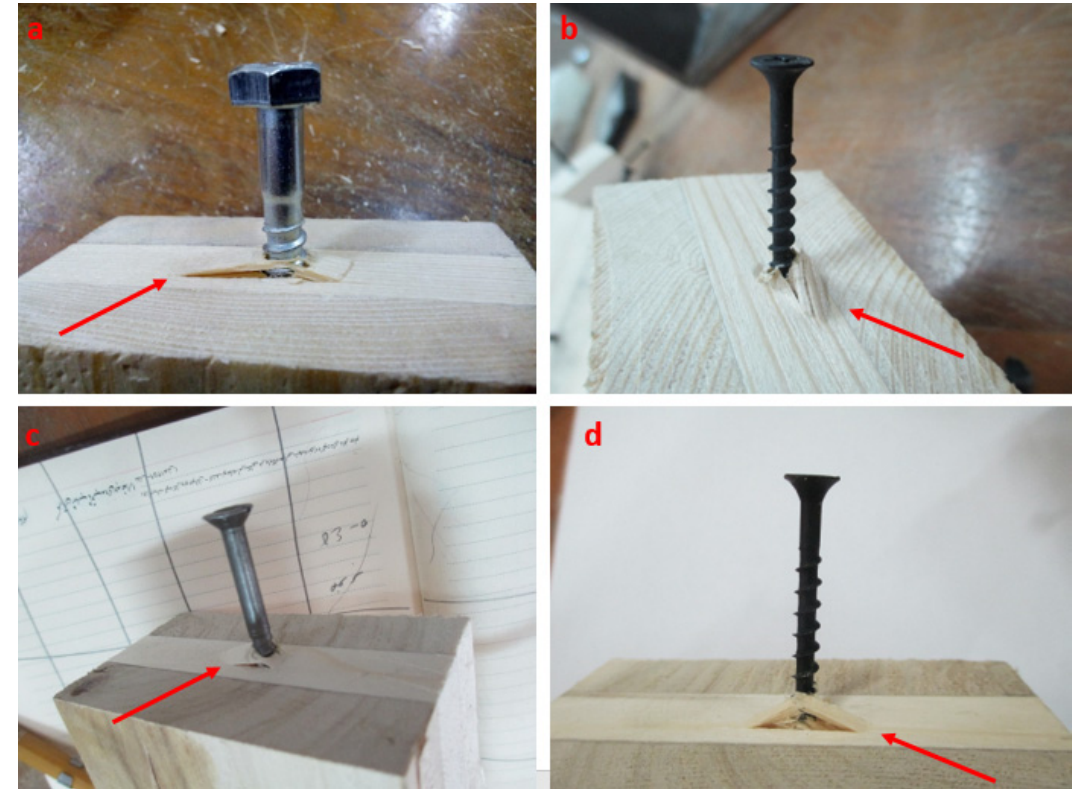
Figure 7. Typical failure modes of CLT members under the withdrawal load parallel to the grains (T direction). ( a – d ) Tearing of adjacent fibers around the fasteners.